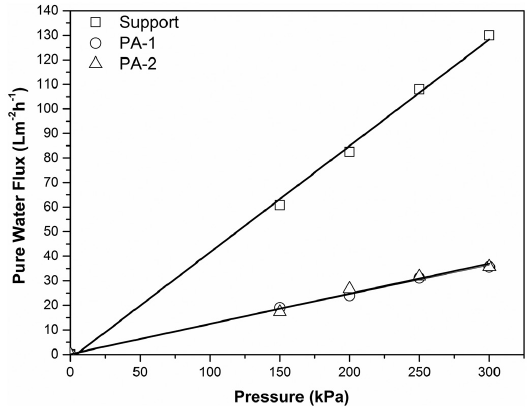
Figure 5. Pure water flux of the support and composite